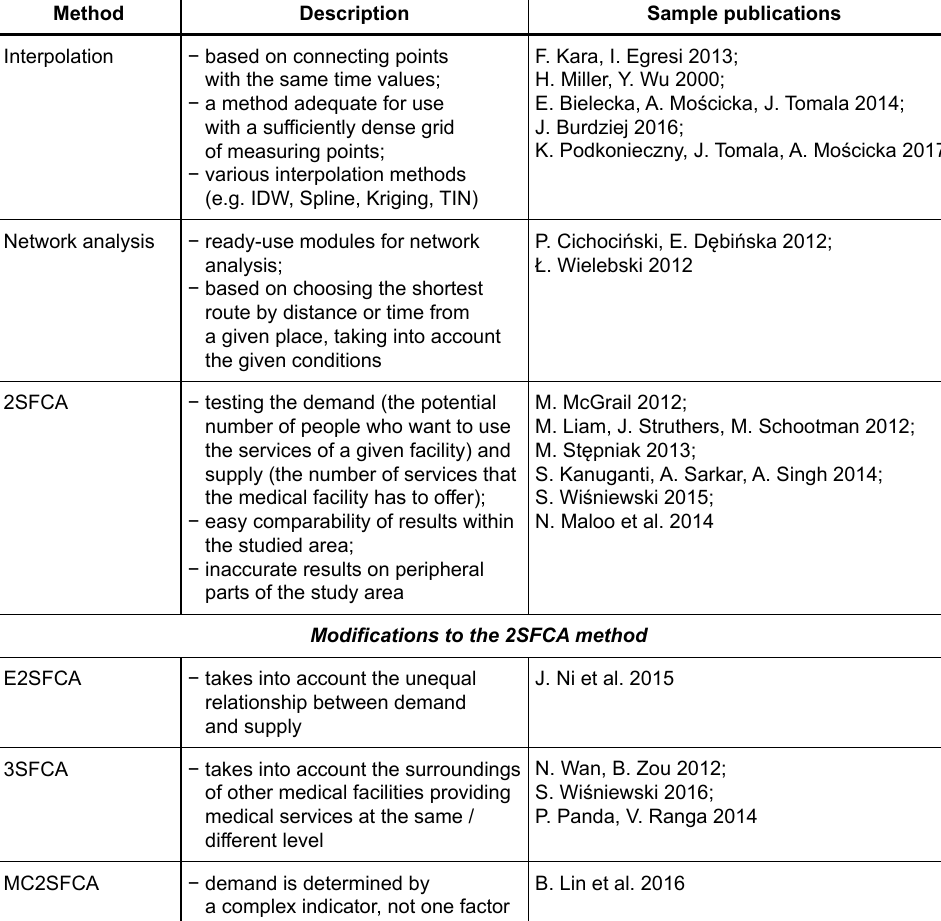
Table 1. Most frequently applied methods in studies on time availability (own study)